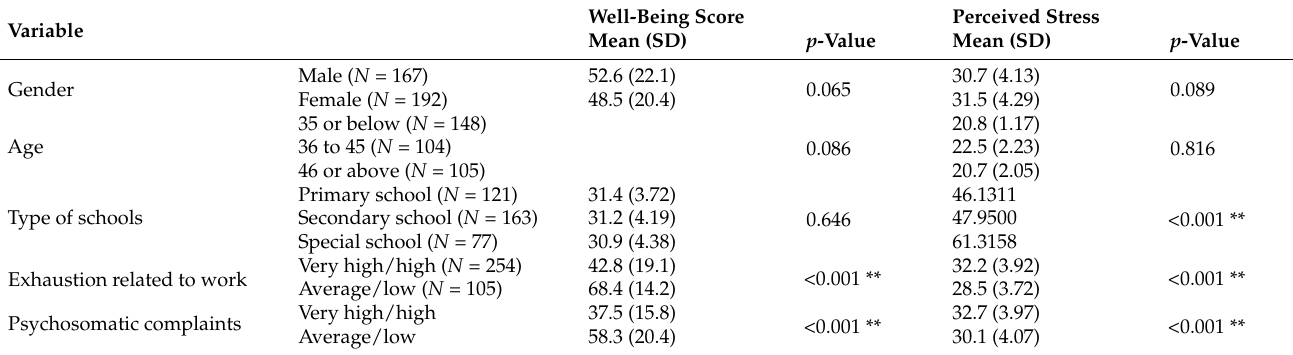
Table 4. Well-being score and perceived